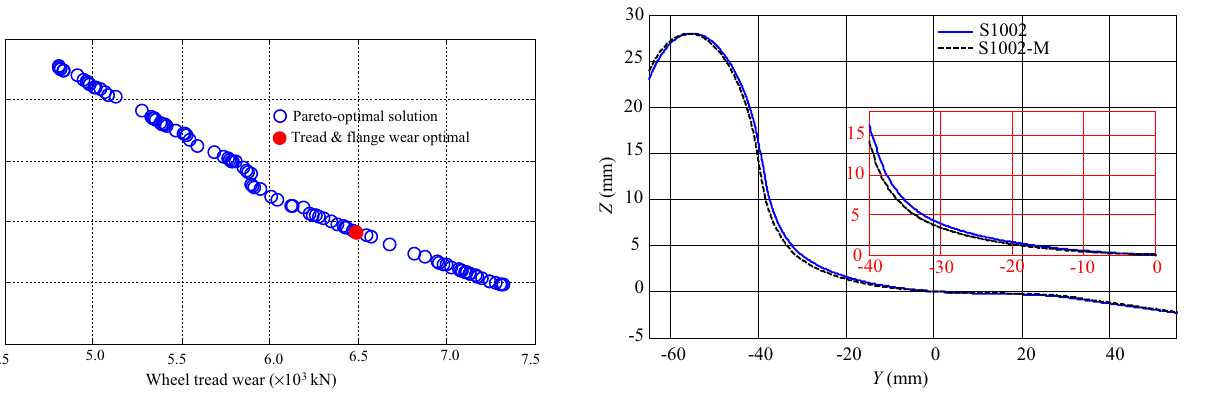
Fig. 14 Multi-objective optimization results by KSM–PSO Fig. 15 Comparison between the S1002 and S1002-M